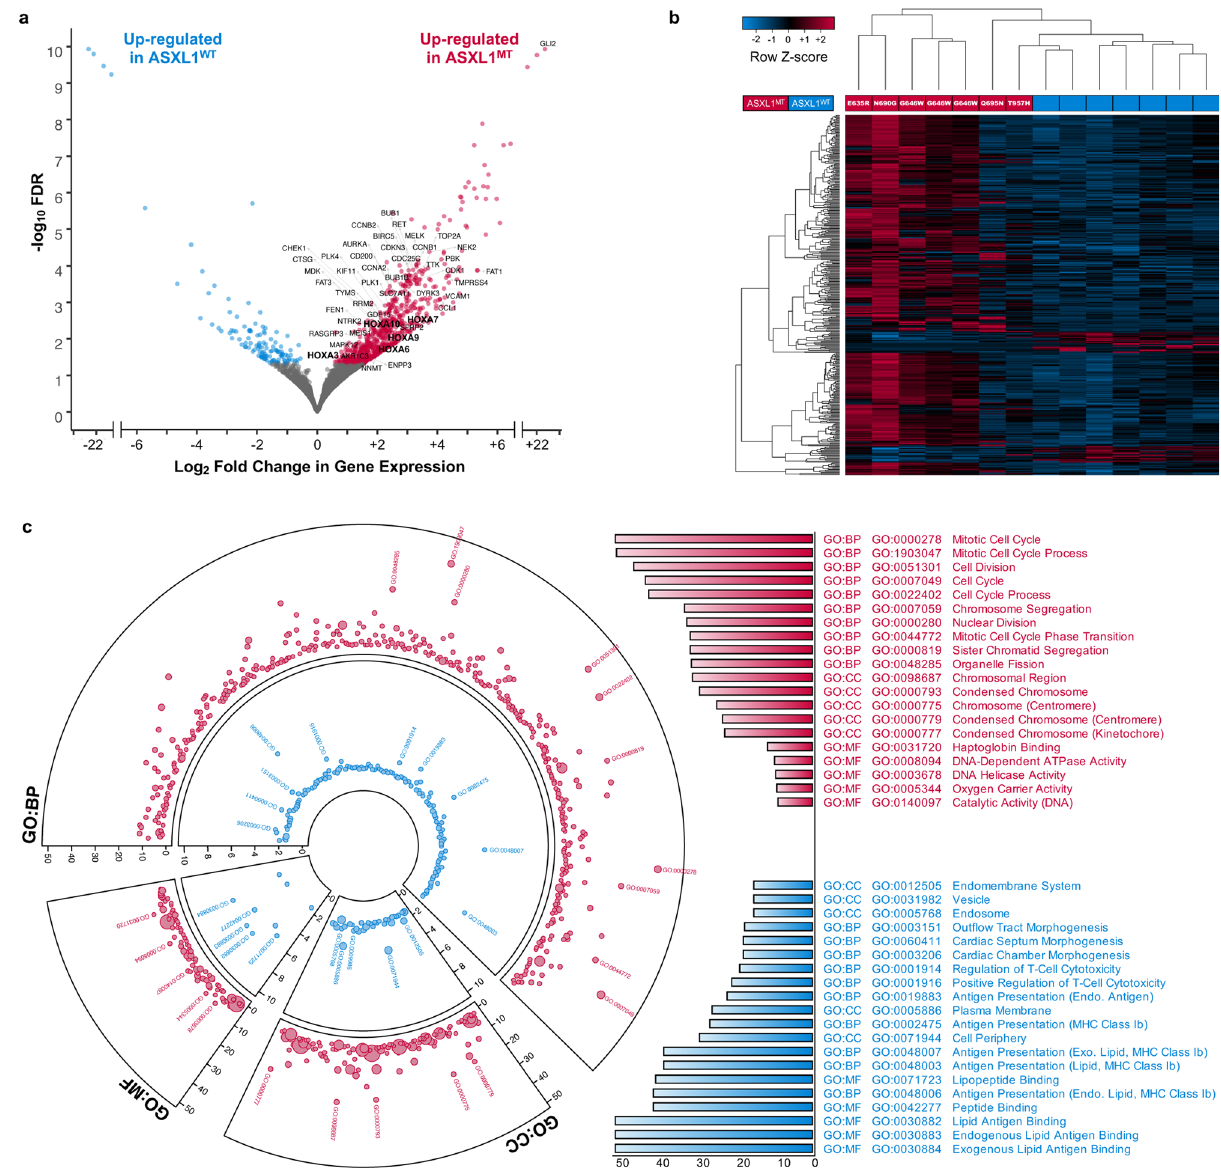
Fig. 2 The transcriptome of ASXL1 MT CMML is characterized by transcriptional up-regulation of key mitotic pathways and leukemogenic driver genes. a Volcano plot showing a predominance of transcriptional up-regulation in ASXL1 MT CMML with a limited number of genes being down-regulated. Up- regulated therapeutic targets with therapeutic agents either being available or currently under development are labeled. Also labeled are the members of the posterior HOXA cluster including the leukemogenic driver HOXA9 and its co-factor MEIS1 (bold). b Heatmap showing the separation of ASXL1 MT and ASXL1 WT CMML by unsupervised hierarchical clustering of all differentially expressed genes with FDR < 0.010. c Circos plot showing the up-regulation of mitotic activity and down-regulation of MHC class I mediated antigen presentation and cytotoxic T-cell activity in ASXL1 MT CMML (red: up-regulated in ASXL MT CMML, blue: up-regulated in ASXL WT CMML). Bar graph showing the top hits in each gene ontology category (GO: Gene Ontology; BP: Biological Process; MF: Molecular Function; CC: Cellular Compartment). Axes represent the statistical signi fi cance of the gene ontology terms and the size of the markers is proportional to the number of genes per